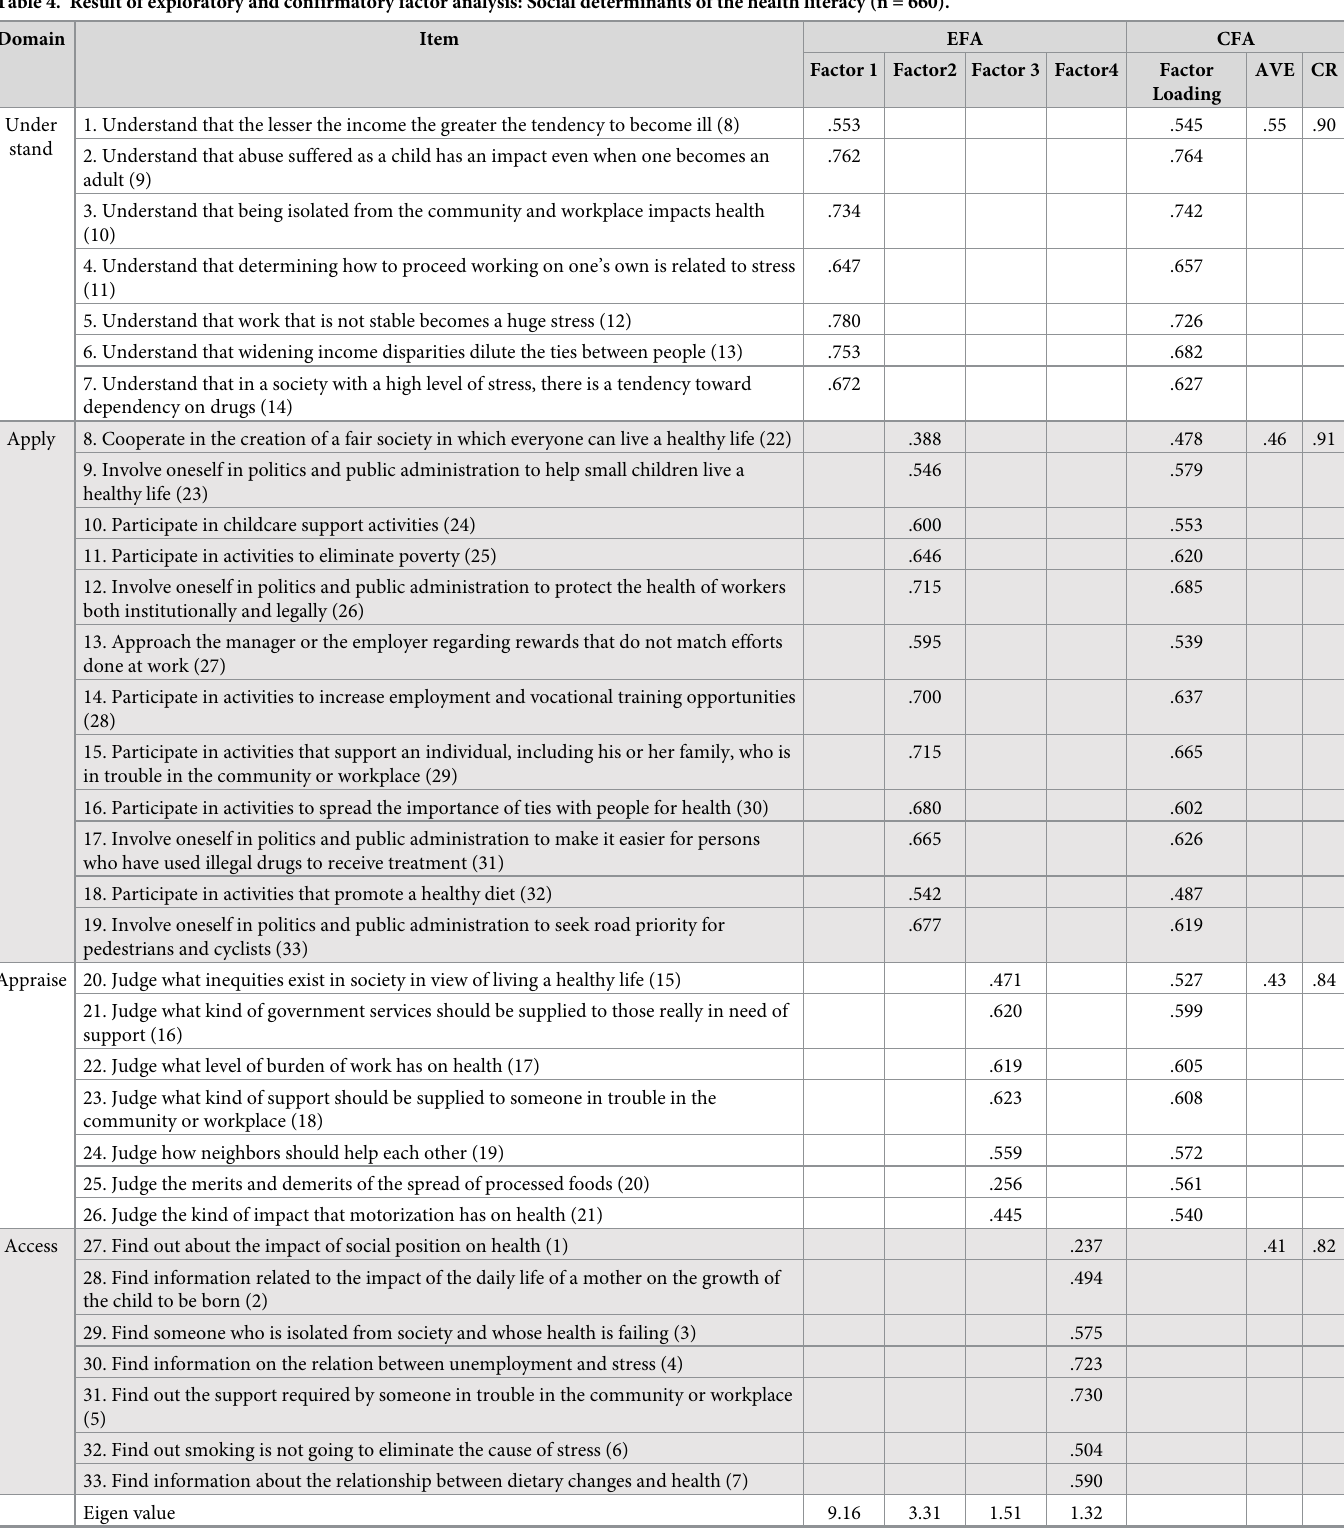
Table 4. Result of exploratory and confirmatory factor analysis: Social determinants of the health literacy (n =